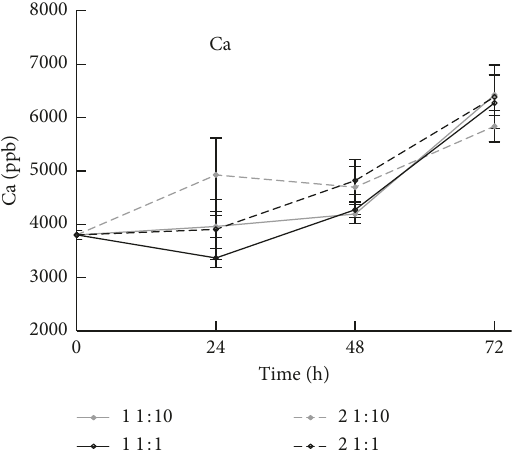
Figure 8: Ca concentration as a function of time in acetate buffer (5 · 10 − 3 M) for Colonies 1 and 2 at 1:10 and 1:1 Water Kefir/metal solution ratios. Conditions: 5% sucrose and initial pH � 4.5. n �